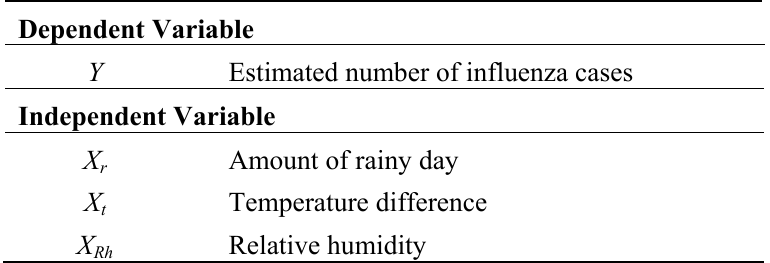
Table 1. Variables in the multiple regression models